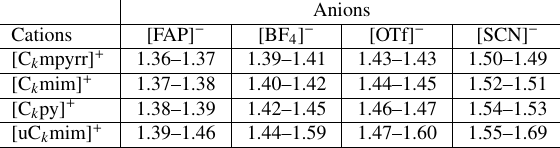
Table 4. Refractive index of ILs with cations bearing side chains of length k = 2 (first value) and k = 5 (second value).